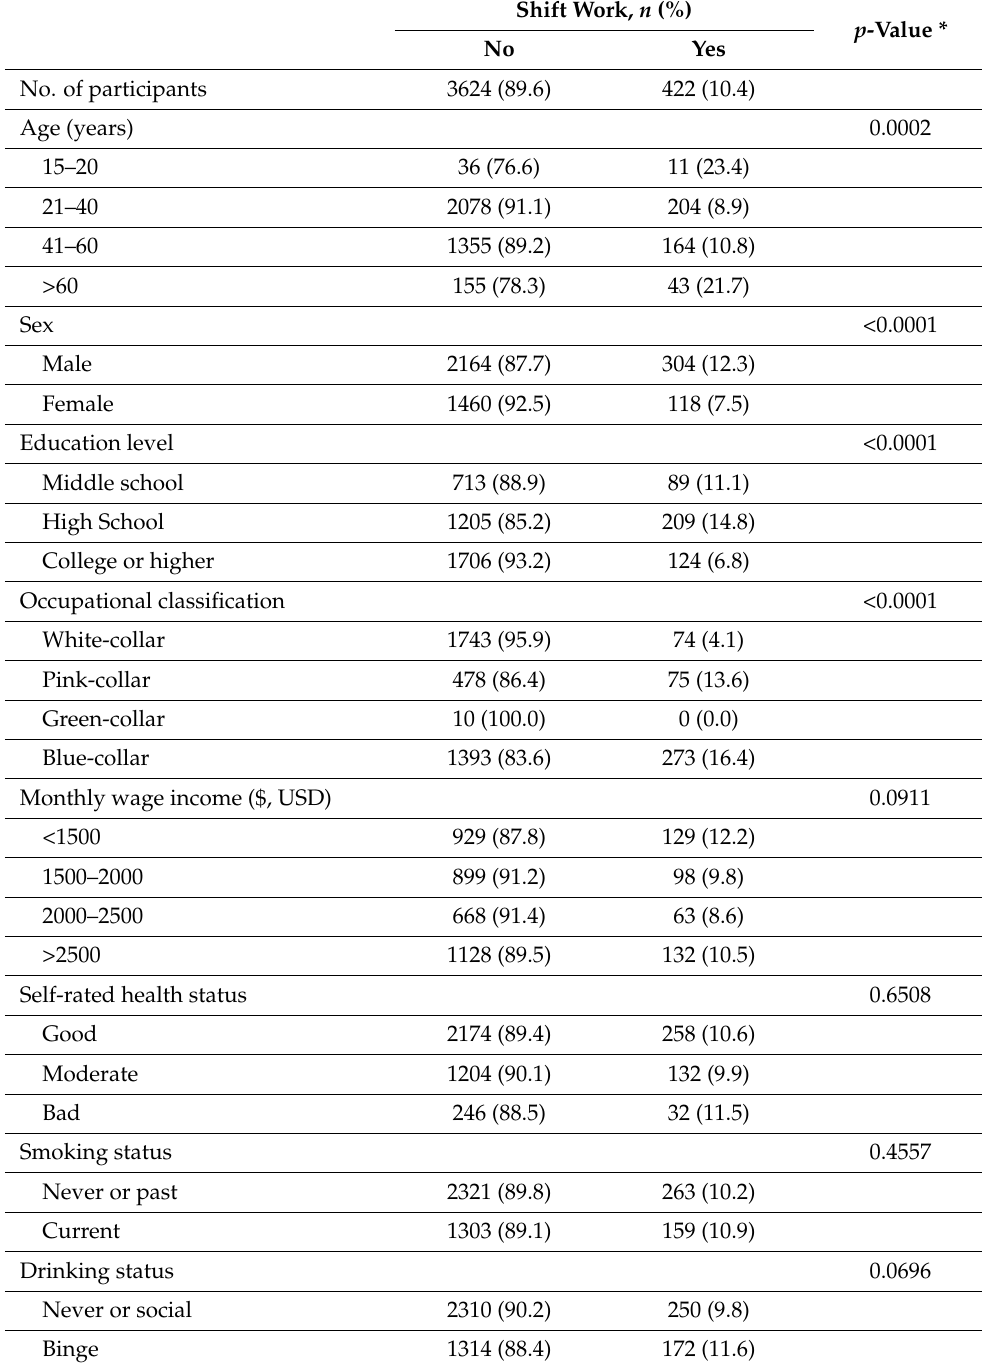
Table 1. General characteristics of the study participants at baseline according to shift work in